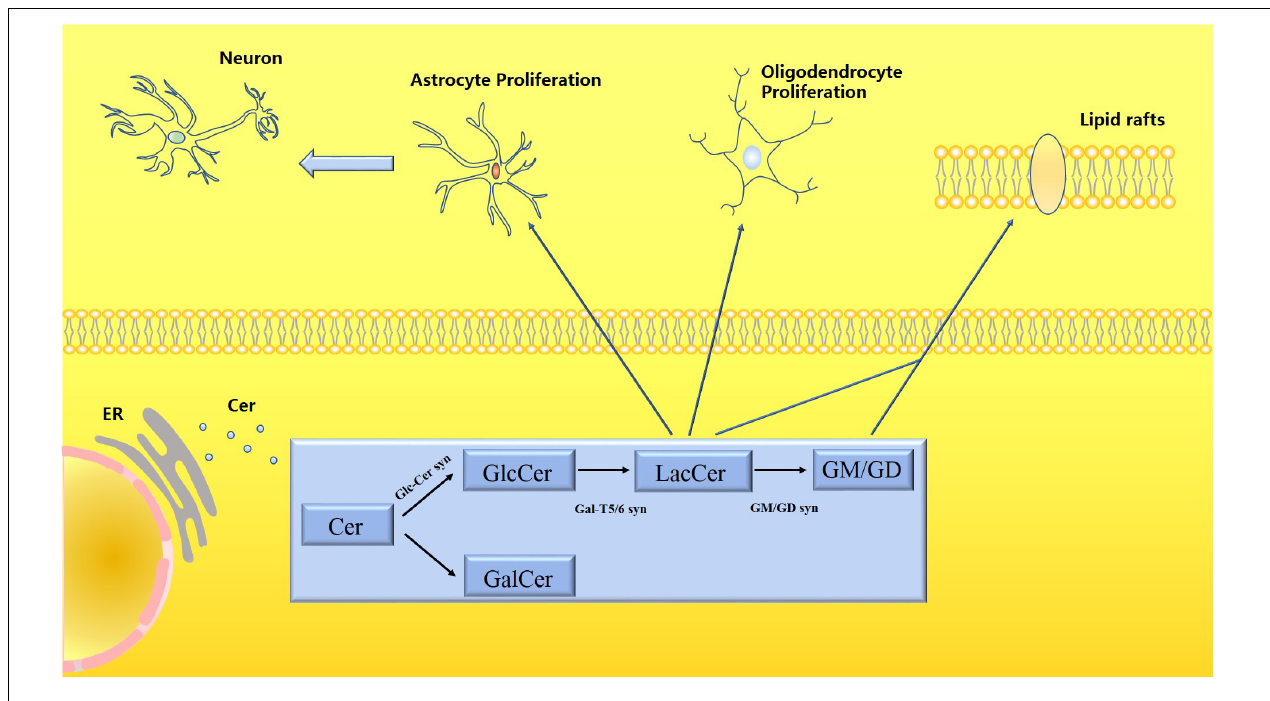
FIGURE 2 | Schematic diagram of the metabolism of LacCer and gangliosides. Ceramide (Cer) is processed in the endoplasmic reticulum to produce glycosphingolipids (GSLs), which are divided into glucosylceramide (GlcCer) and galactose ceramide (GalCer). LacCer participates in the activation of astrocytes and microglia to trigger neuroinflammatory responses. Both LacCer and gangliosides participate in the formation of lipid rafts, which have a stable membrane structure, regulating material transportation and signal